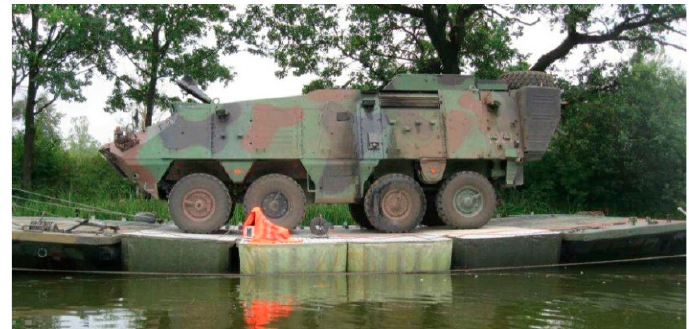
Figure 12. An example of a military pontoon bridge made of FRP composites [56].